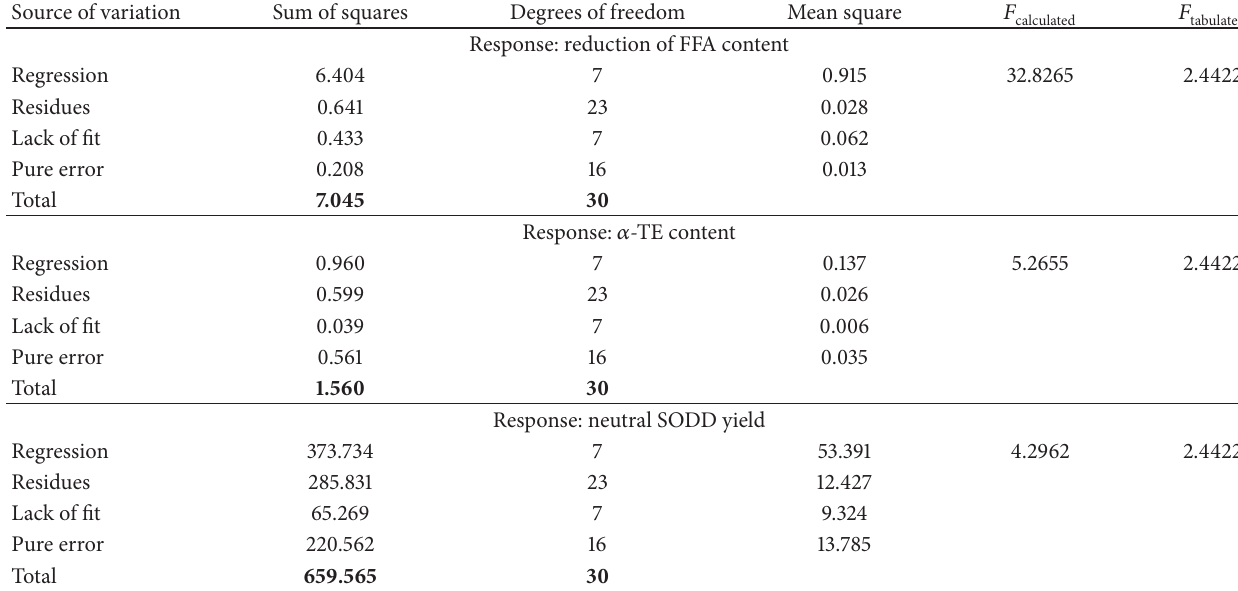
Table 5: ANOVA of the responses in the second experimental